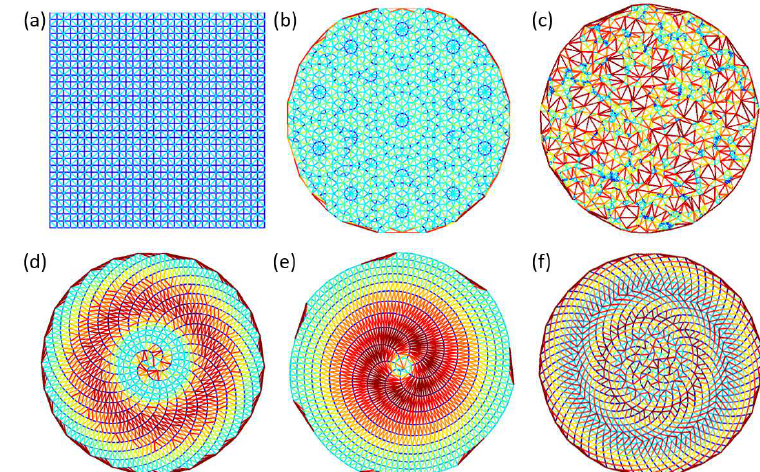
Figure 5. Delaunay triangulation with color-coded edge according to their lengths. ( a ) N = 1024 square array; ( b ) N = 1108 Penrose array; ( c ) N = 1000 pseudo-random array; ( d ) N = 1000 µ -spiral array; ( e ) N = 1000 π -spiral array; and ( f ) N = 1000 τ -spiral array. The edge lengths increase from blue (shortest edge of Delaunay triangulation of each array) to red (longest edge of Delaunay triangulation of each